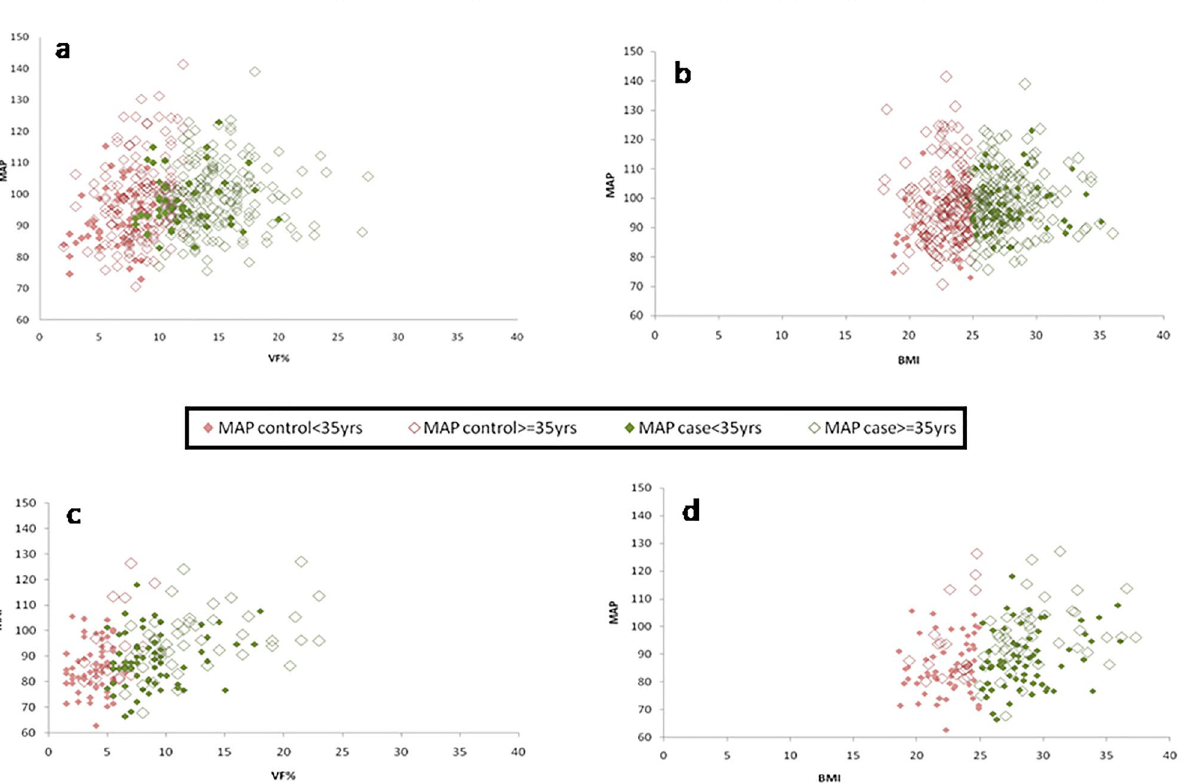
Figure 4. Association between (i) VF% and MAP ( a & c ) (ii) BMI and MAP ( b & d ) in the total male and female population